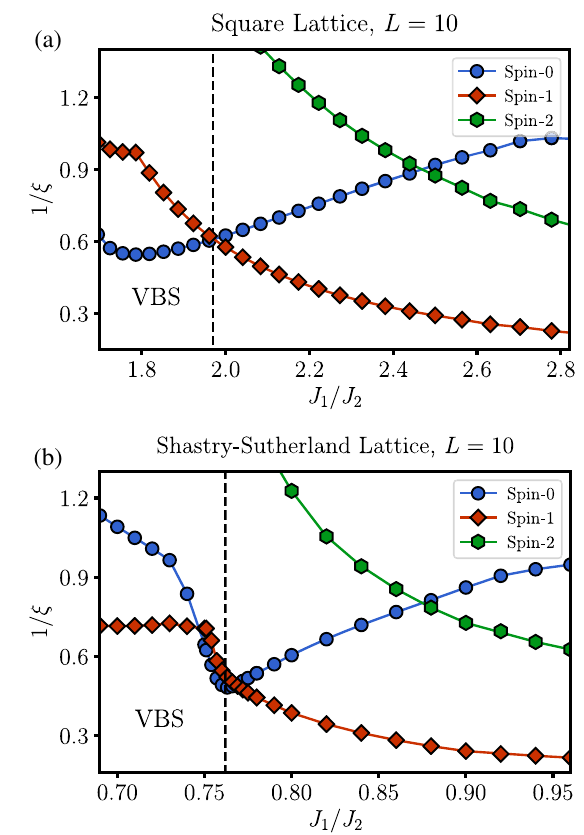
FIG. 9. The correlation length spectrum for (a) the J 1 - J 2 model in the spin- 1 = 2 square lattice ( χ ¼ 2000 ) and (b) the Shastry- Sutherland model ( χ ¼ 4000 ). The correlation length spectrum coincides with the excitation level-crossing spectrum in Fig. 2 of Ref. [50] (after switching J 2 =J 1 to J 1 =J 2 ). For the value of J 1 =J 2 smaller than the range shown in the figure, we get the collinear striped AFM order (DVBS) for the square (Shastry-Sutherland) lattice. The level-crossing behaviors for both models are similar in the N´eel ordered